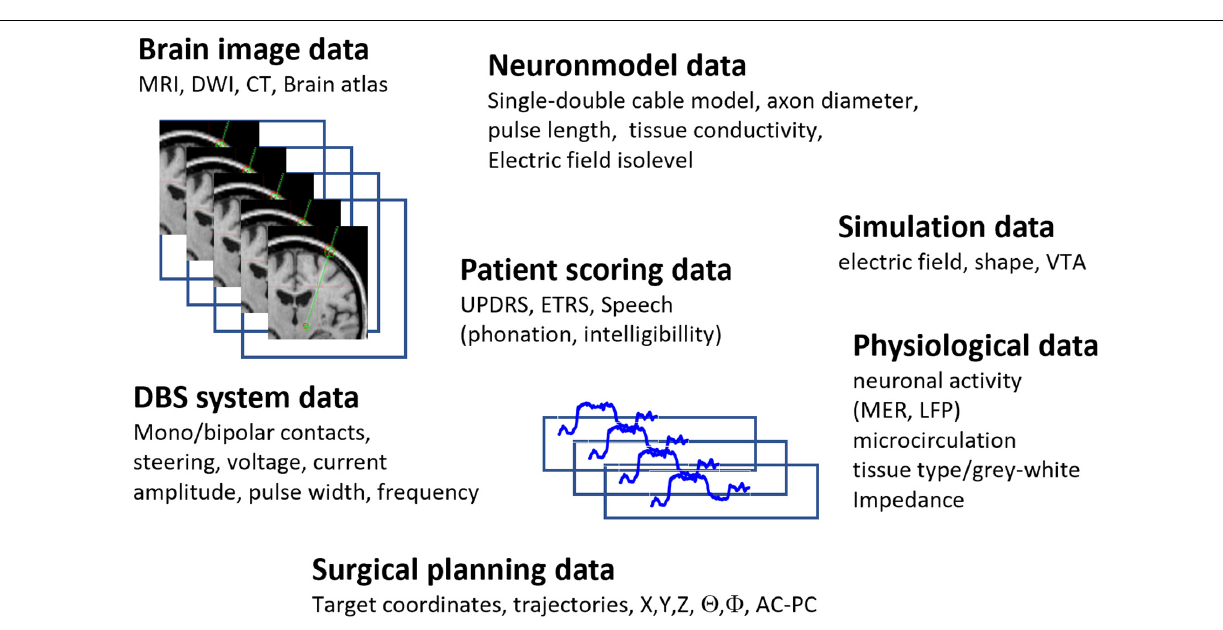
FIGURE 4 | Example of multidimensional large-scale data generated during DBS planning, implantation and postoperative follow up. The data can differ between